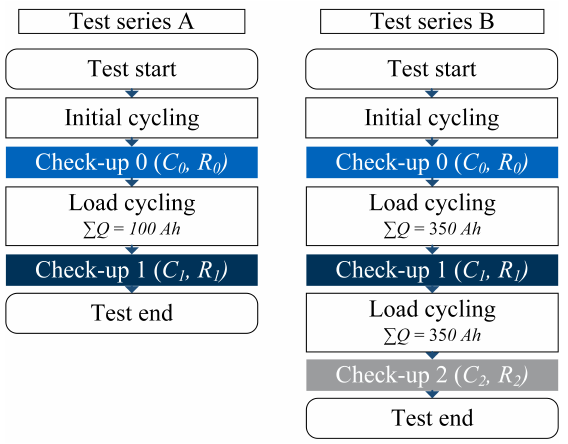
Figure 4. Testing procedures for test series A and B: Sequential order of initial cycling, check-up testing, and load cycling. For test series A, check-up 1 constitutes one available condition for performing a sensitivity analysis. For test series B, check-ups 1 and 2 constitute two available